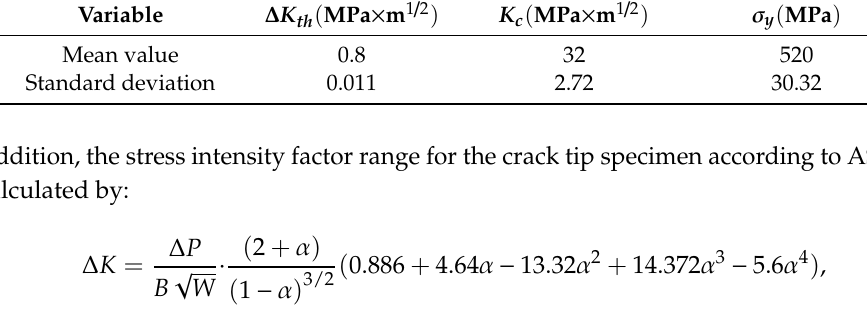
Figure 4. Experimental data under constant amplitude loading. Table 3. Statistical characteristics of model parameters. Table 1. Material and geometry properties of plate specimens.